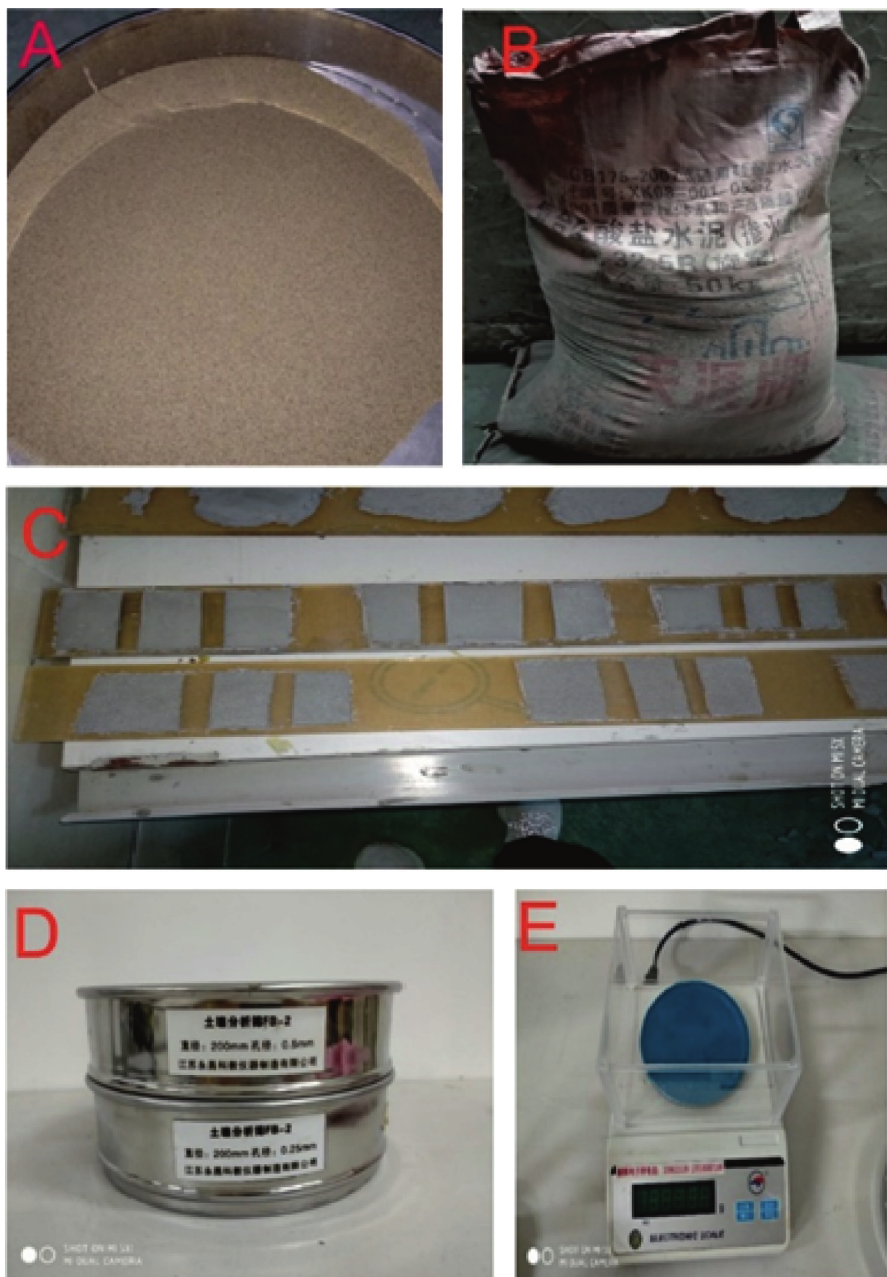
Figure 2: Materials and instruments used in the test: (a) Fujian standard sand for testing; (b) cement; (c) plexiglass sample after applying cement mortar; (d) soil analysis sieves with the apertures of 0.25mm and 0.5mm; (e) electronic